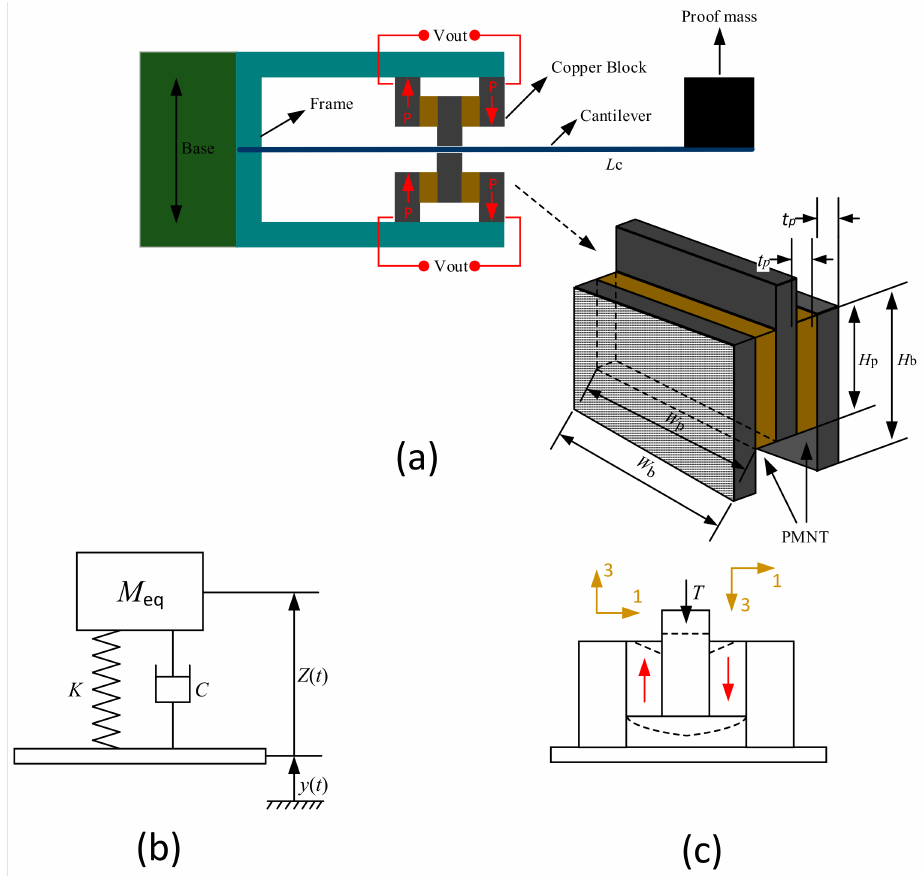
Figure 7. ( a ) Schematic and ( b ) SDOF model of the proposed S-CANDLE device. The arrows in the PMNT wafers indicate the poling direction. ( c ) Force analysis of the middle copper block and one PMN-PT wafer. Adapted from [45].